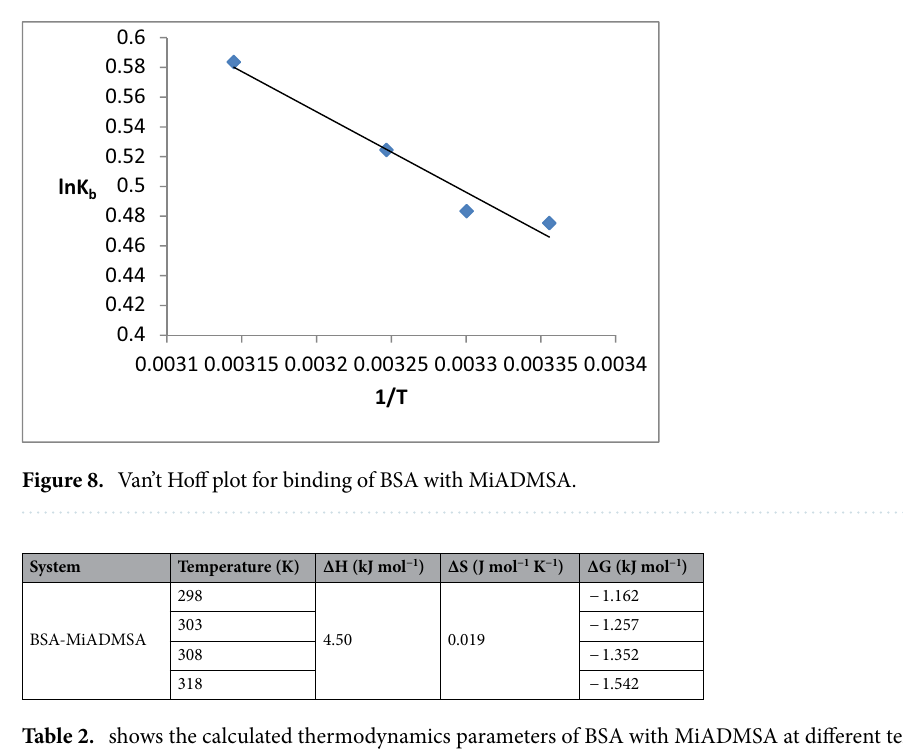
Table 2. shows the calculated thermodynamics parameters of BSA with MiADMSA at different temperatures.